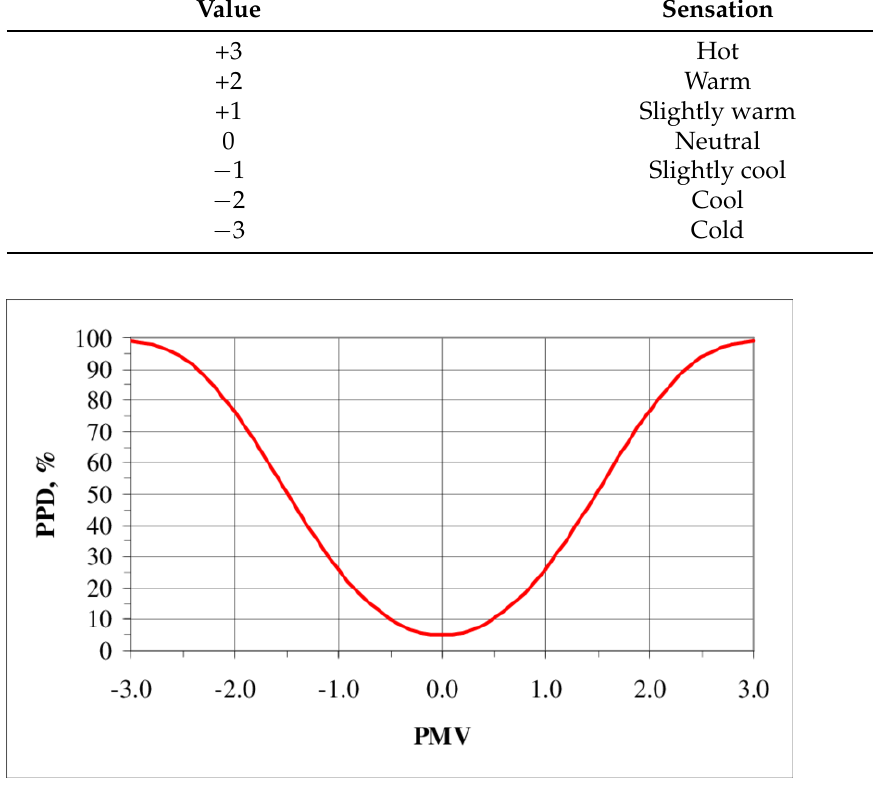
Figure 1. Predicted percentage dissatisfied (PPD) as a function of predicted mean vote